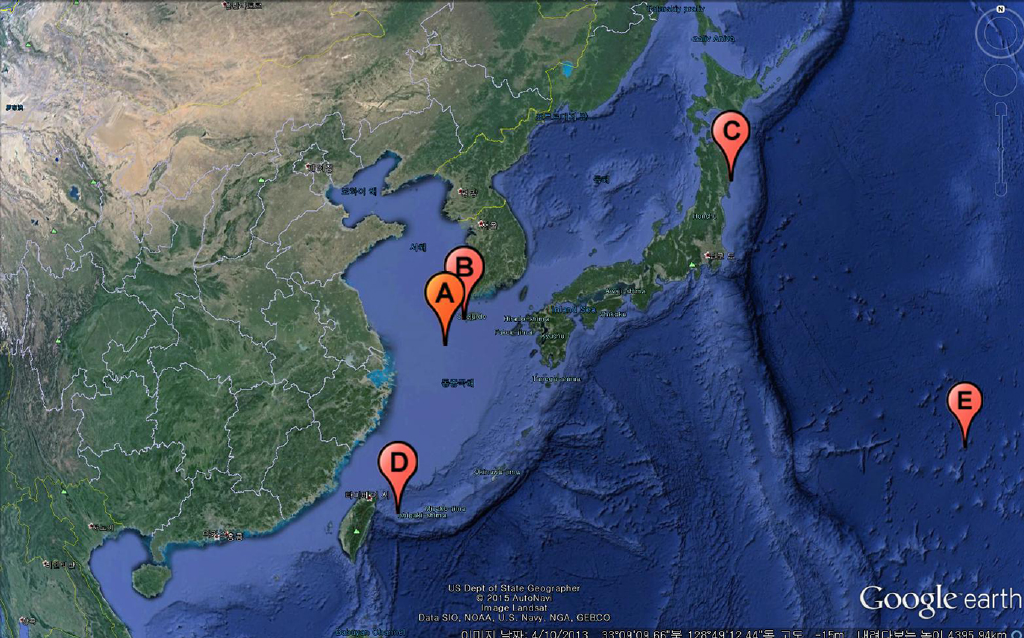
Figure 1. Geographical locations of (a) Ieodo Ocean Research Station, (b) Gosan, Korea, (c) Ryori, (d) Yonagunijima, and (e) Minamitor- ishima,